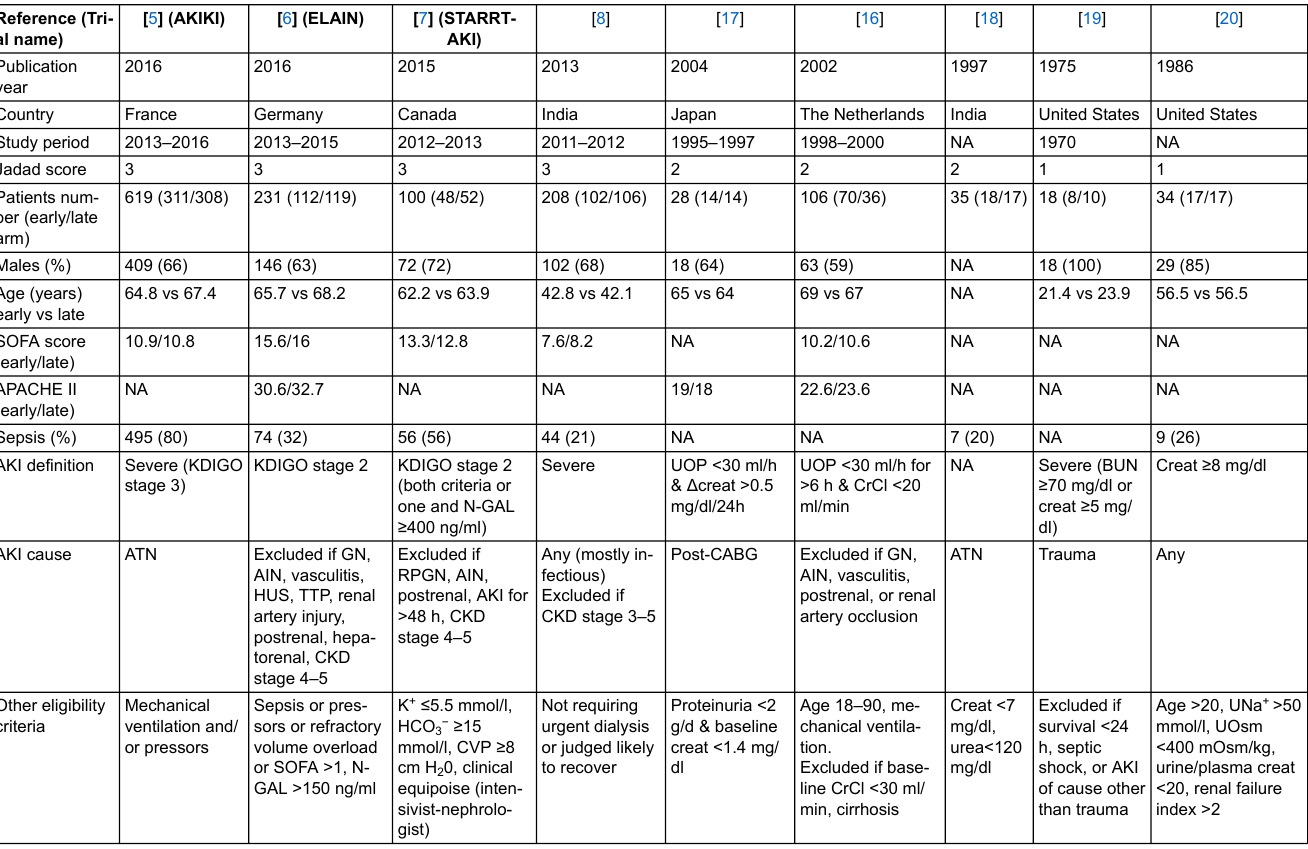
Table 1: Characteristics of the selected